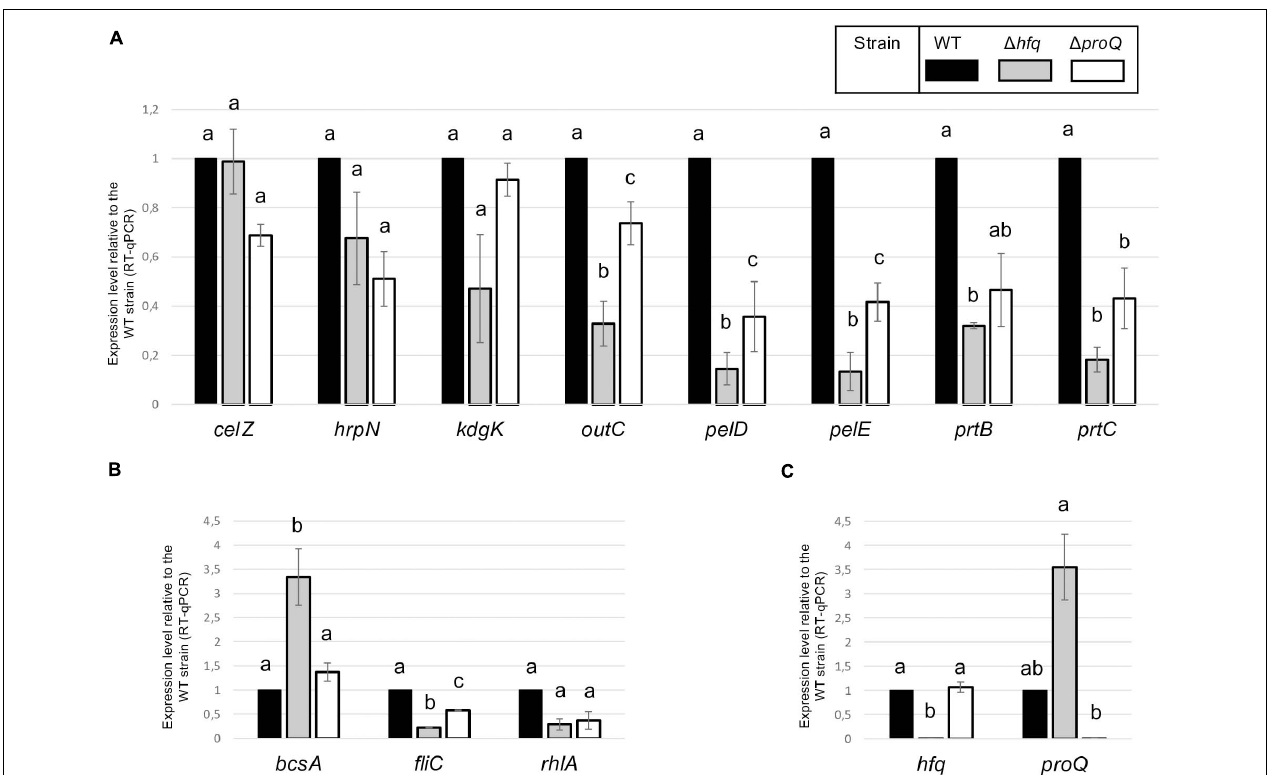
FIGURE 5 | RNA amounts in the hfq and proQ mutant strains. Gene expression levels relative to the WT strain were evaluated in the two mutants by RT-qPCR. (A) Genes encoding late virulence factors or associated with late virulence factors; (B) Genes encoding early virulence factors such as adherence and motility factors; (C) Expression levels of hfq and proQ were measured in the different mutants. Non-capital letters a, b, and c are presented above the histograms. Groups with the same letter are not detectably different (are in the same set) and groups that are detectably different get different letters (different sets). Groups can have more than one letter to reflect “overlap” between the sets of groups. Note that if the groups have the same letter, this does not mean they are the same, just that there is no evidence of a difference for that pair ( P < 0.05, t -test).